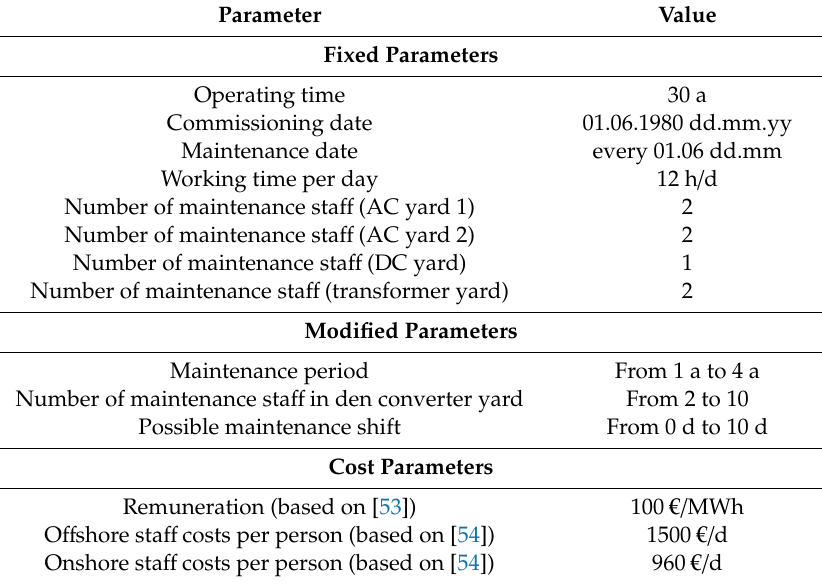
Table 8. Case study parameters.